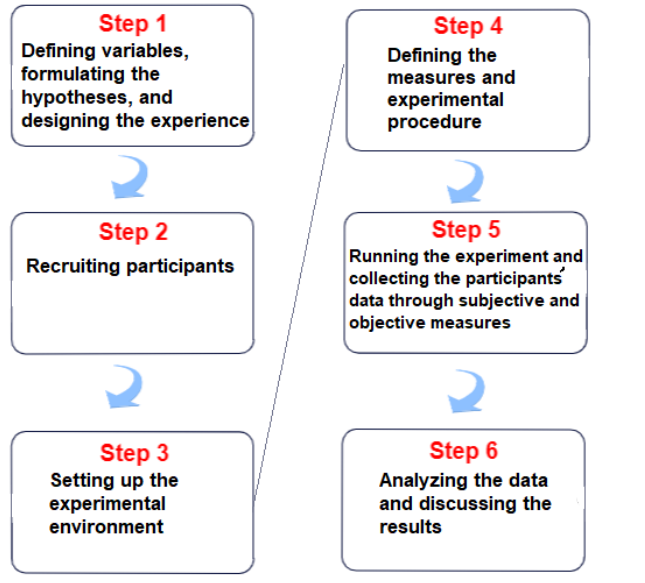
Figure 1. The stages of the experimental